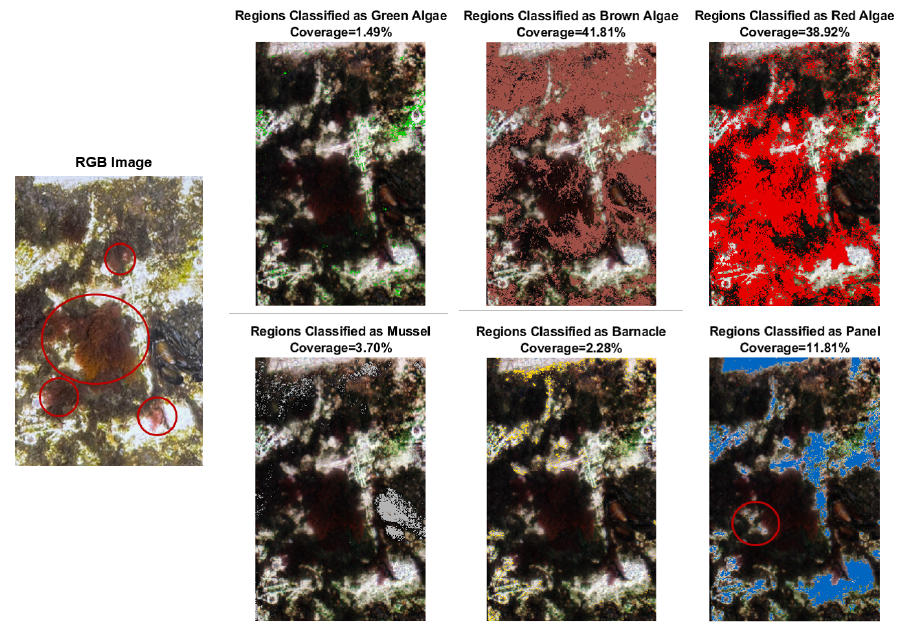
Figure 12. Classification and coverage percentage of biofouling for a medium-fouled panel obtained from using the WNN. On the leftmost side, the RGB image of the panel taken with a commercial camera is shown. Some of the red algae detected under visual inspection of the panel are encircled to qualitatively compare with the classification with the WNN